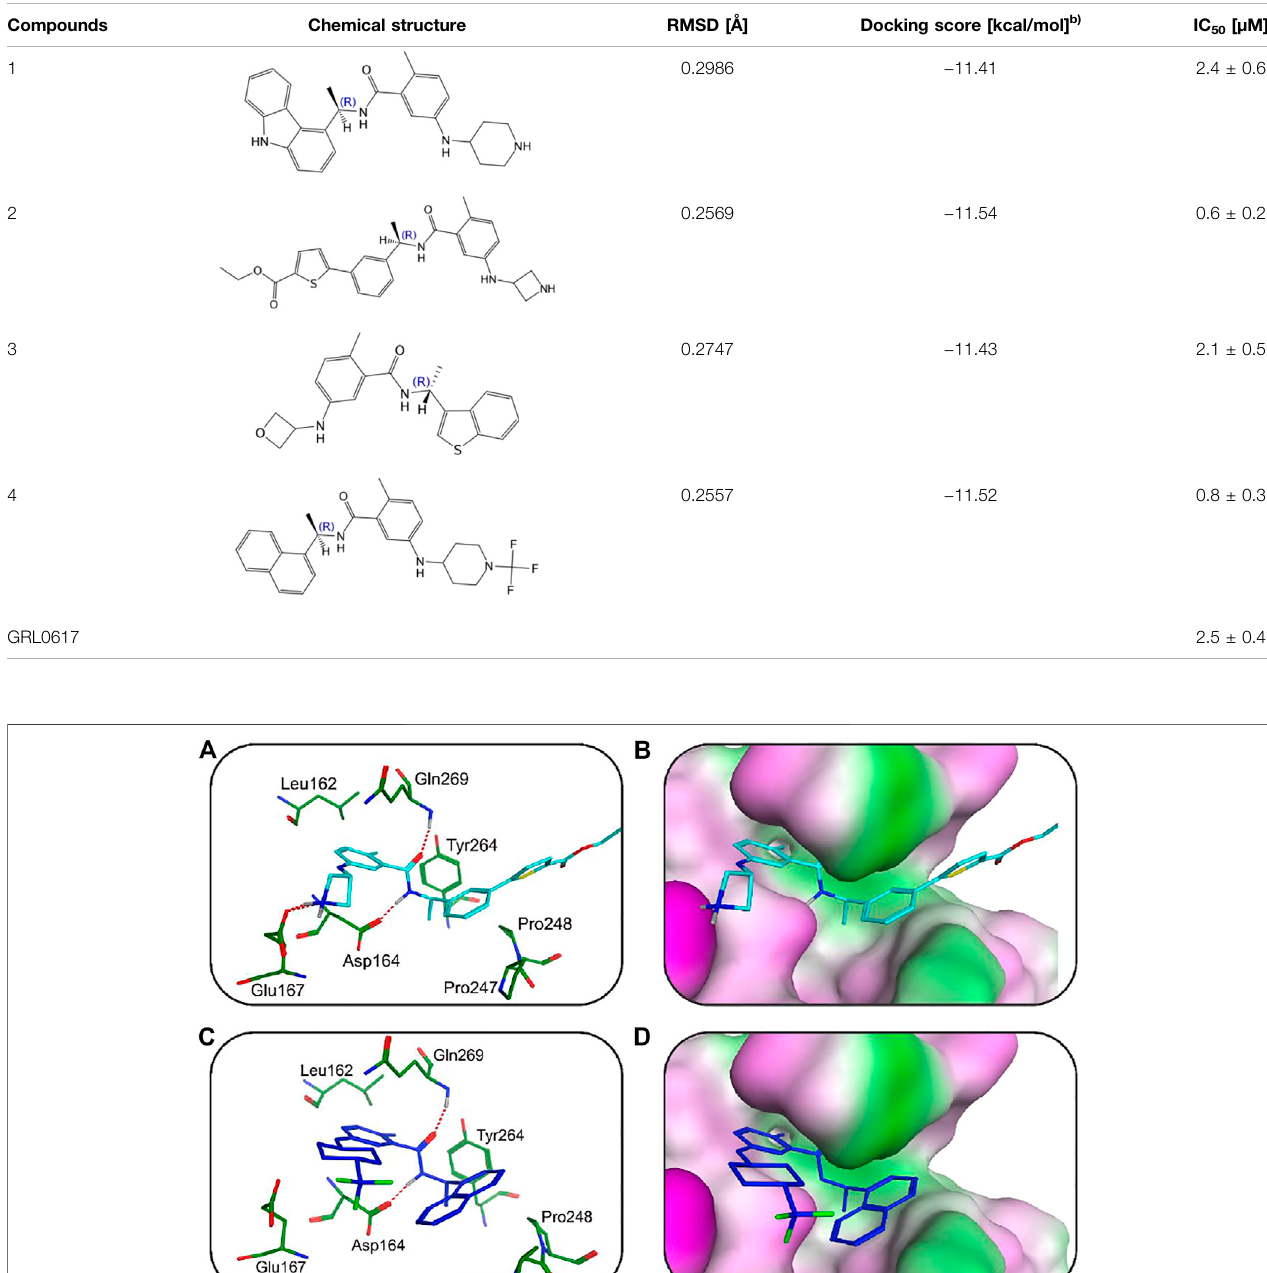
compounds match well with the pharmacophore features of